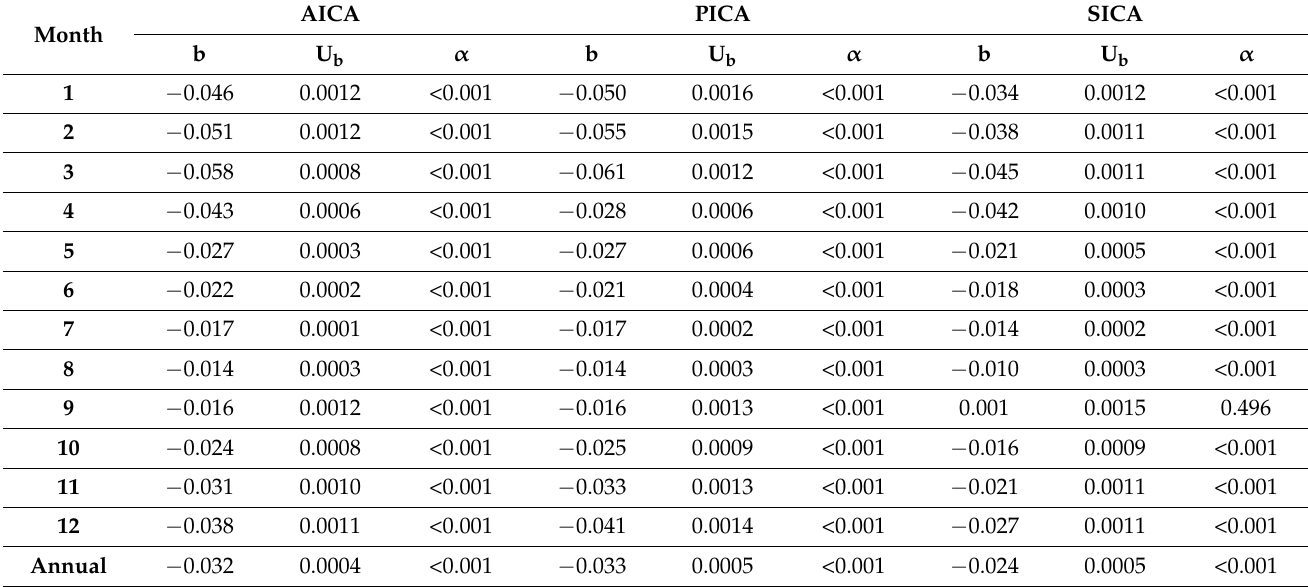
Table 3. Monthly mean SIT trend b (m per year) with its uncertainty U b and confidence level α for AICA, PICA, and SICA over